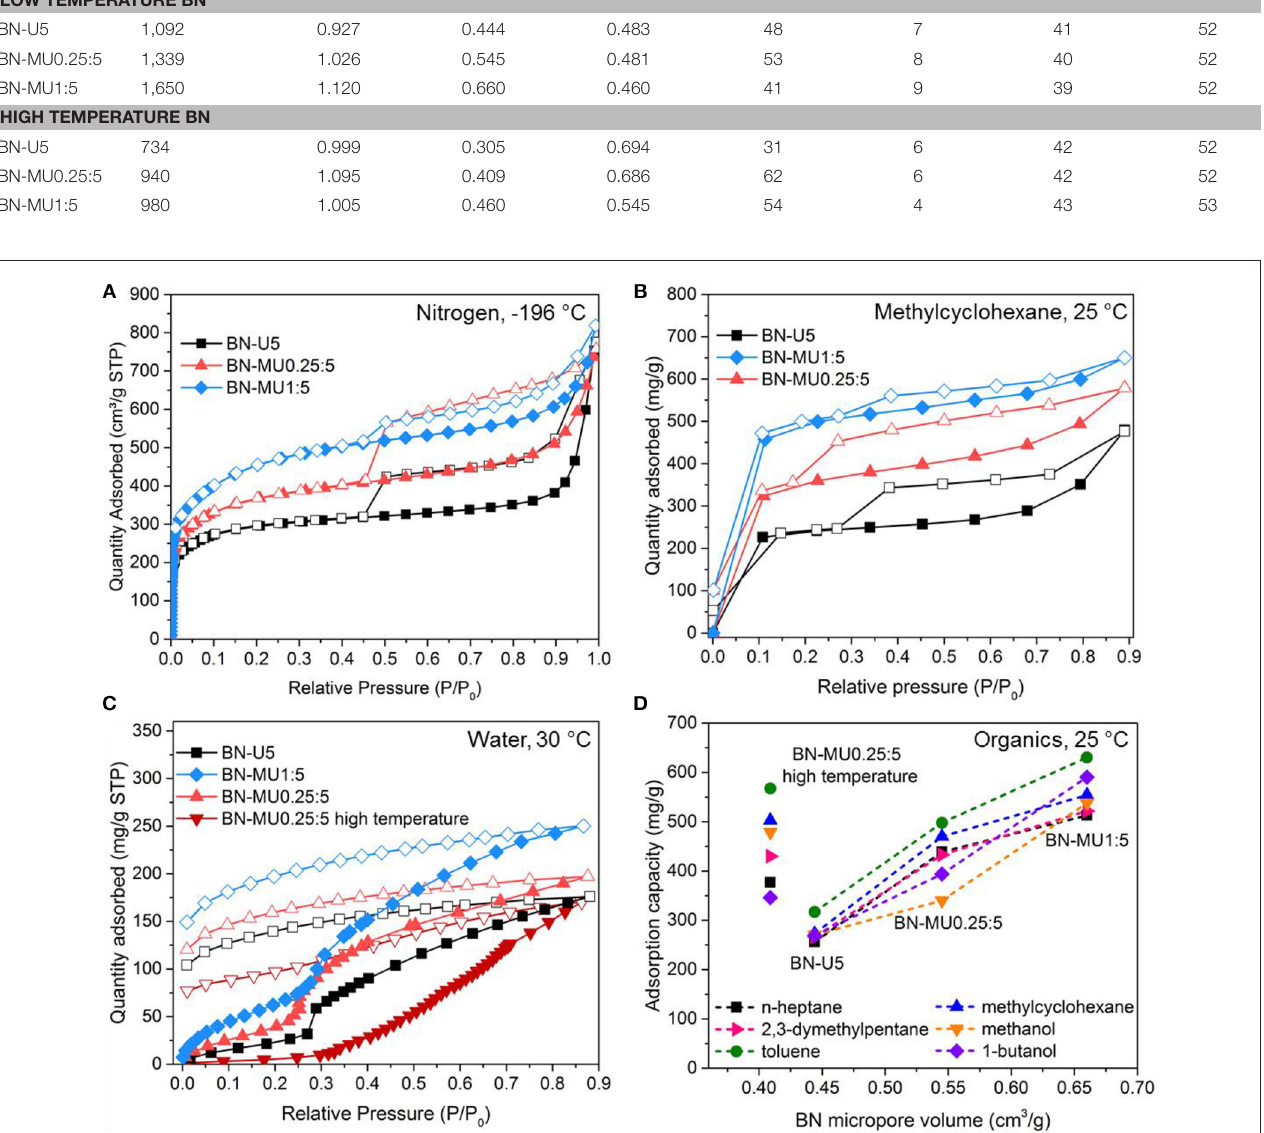
FIGURE 1 | Organics and water sorption behaviors of porous BN samples of varying pore structures: (A) N 2 sorption isotherms at − 196 ◦ C for three low temperature porous BN samples, (B) methylcyclohexane vapor sorption isotherms for the same three low temperature porous BN samples at 25 ◦ C, (C) water vapor sorption isotherms for low temperature porous BN and one high temperature porous BN sample at 30 ◦ C, (D) organic vapor sorption capacity at 0.6 P/P 0 vs. micropore volume of porous BN for three low temperature samples and a high temperature BN. Open symbols in the figures represent desorption.